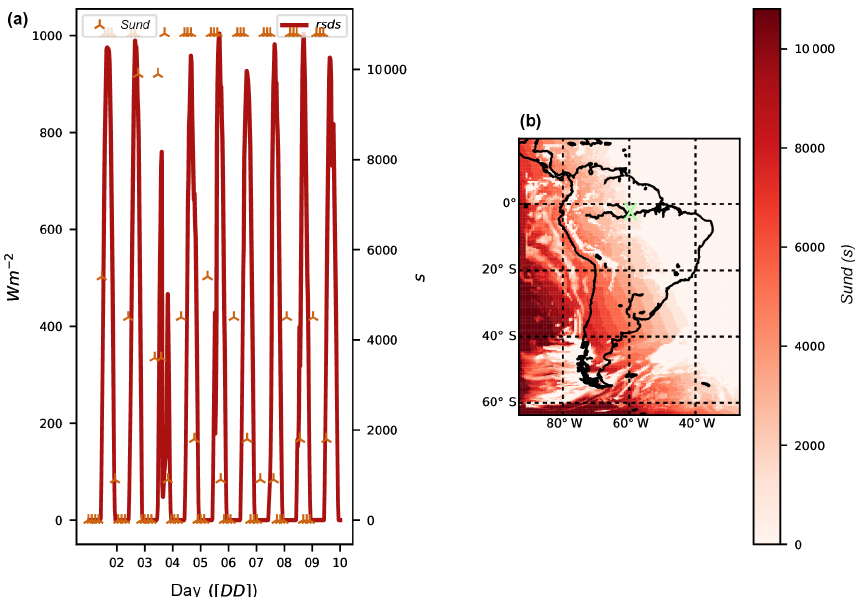
Figure 2. Temporal evolution at 62 ◦ 4 (cid:48) 38.00 (cid:48)(cid:48) S, 4 ◦ 58 (cid:48) 55.51 (cid:48)(cid:48) W (a) of shortwave downward radiation (rsds, red line, left y axis) and sunshine duration for a 3-hourly 9freq (sund, stars, right y axis). (b) Sunshine length map on 9 December 2012 at 15:00UTC. X denotes the position of the temporal